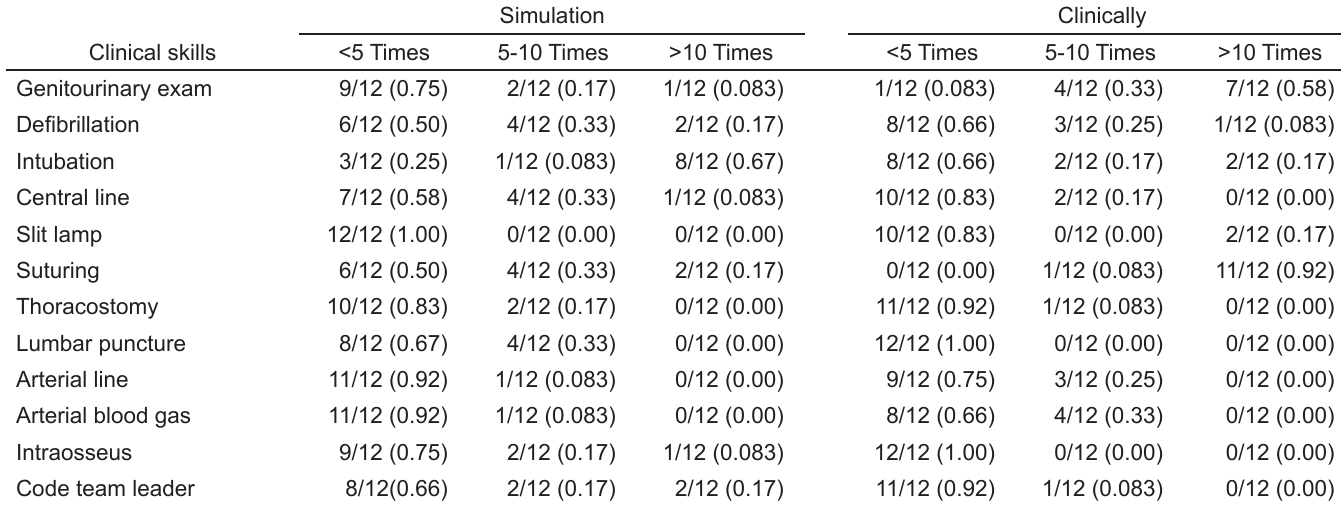
Table 2. Pre-survey frequency of clinical